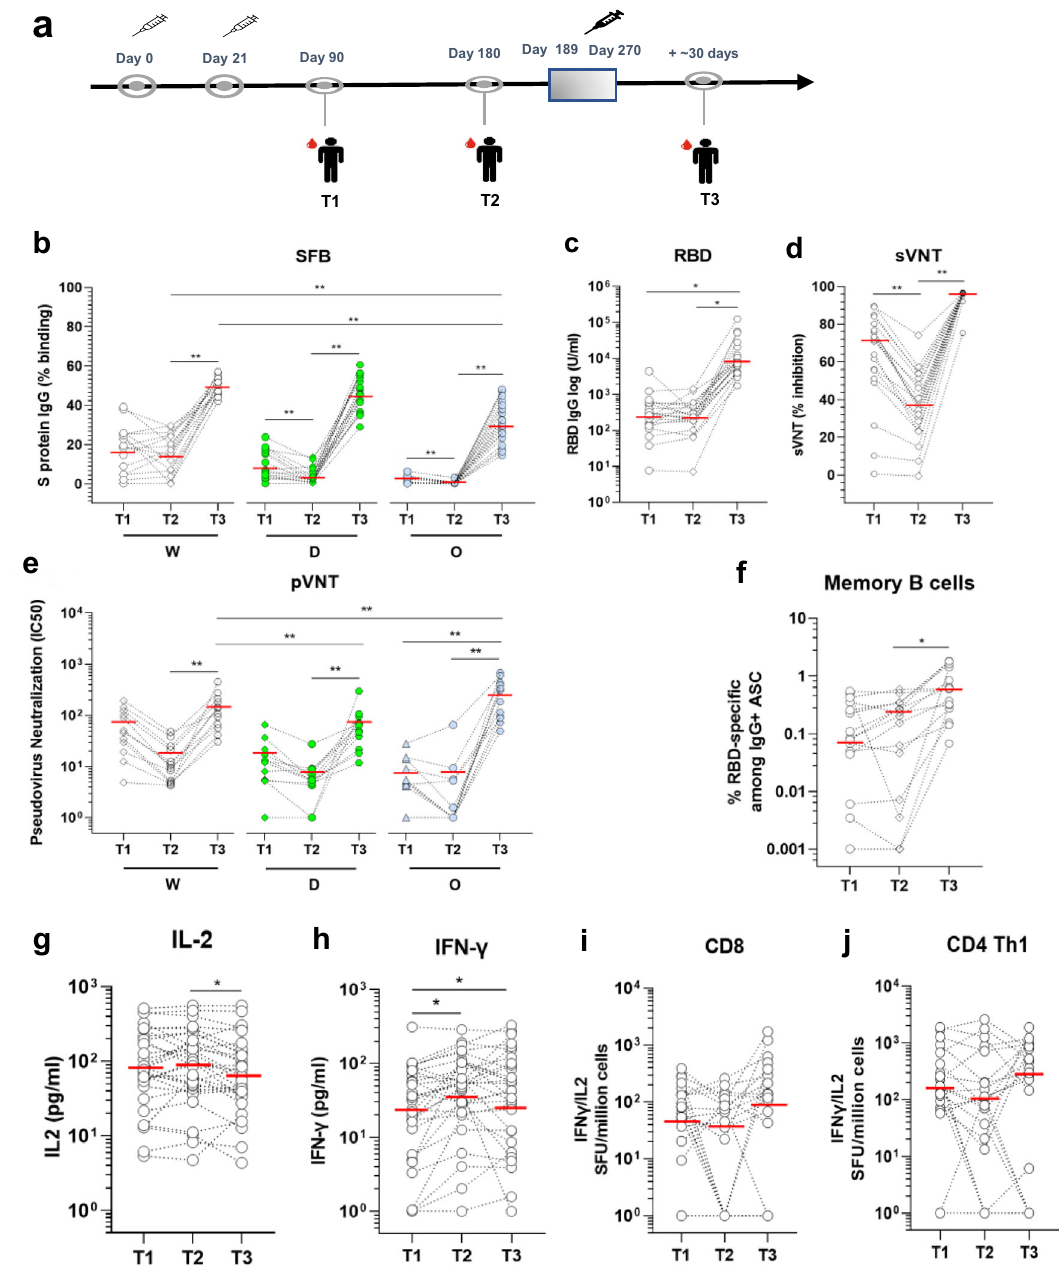
Fig.7 | Anti-SARS-CoV-2 spike protein antibody andT cellresponsebefore and afterthethirdboosterdose.a Bloodsamplingstrategyinsubsetsofthecohortof SingaporeanindividualsmentionedinFig.1.KineticsofIgGresponsewereanalyzed using three serological assays on paired samples taken attime T1(day90), T2(day 180), and T3 (day 189 – 270) post fi rst injection. b SFB assay using the cells expressing the Wuhan ancestral strain (W, white dots), Delta (D, green dots) or Omicron variant (O, blue dots). Median of group values at T1 ( n =16), T2 ( n =20), andT3( n =20)were:19,16.45,and50.2%(W);6.7,2.56,and45,73%(D);and 1,0.18, and 31.65% (O). p <0.001, Friedman test; c Anti-RBD antibodies using the Roche S assay. Median of values ( n =20) at T1, T2, and T3 were 277, 246.8 and 7723U/ml; * p <0.001, Friedman test. d Surrogate virus neutralization test (sVNT). Median values ( n =20) at T1, T2, and T3 were 71.2, 36,94 and 96.4% of inhibition. * p <0.0001, Friedman test. e Neutralization assay using pseudoviruses expressing the SARS-CoV-2 Spike of the Wuhan ancestral strain (W), Delta variant (D) or the Omicronvariant (O) ( n =12). Median of IC50values atT1, T2, and T3are 48.9, 10.2, and 123.2 (W);12.5, 5.3,and 57.1 (Delta); 5.0,1.0, and 248.9 (Omicron) respectively. * p <0.01, Friedman test. f RBD-speci fi c memory B cells. Paired wise comparison of total RBD-speci fi c memory B cells for the analyzed aged group at different days is